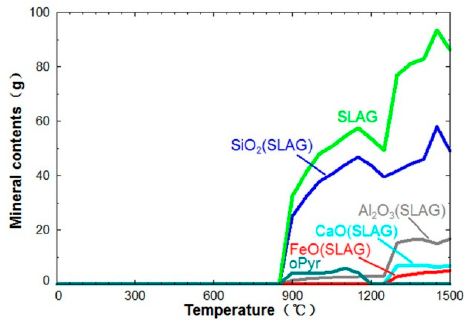
Figure 10. Thermodynamic simulation of mineral transformation in 40%-O 2 gasification condition.